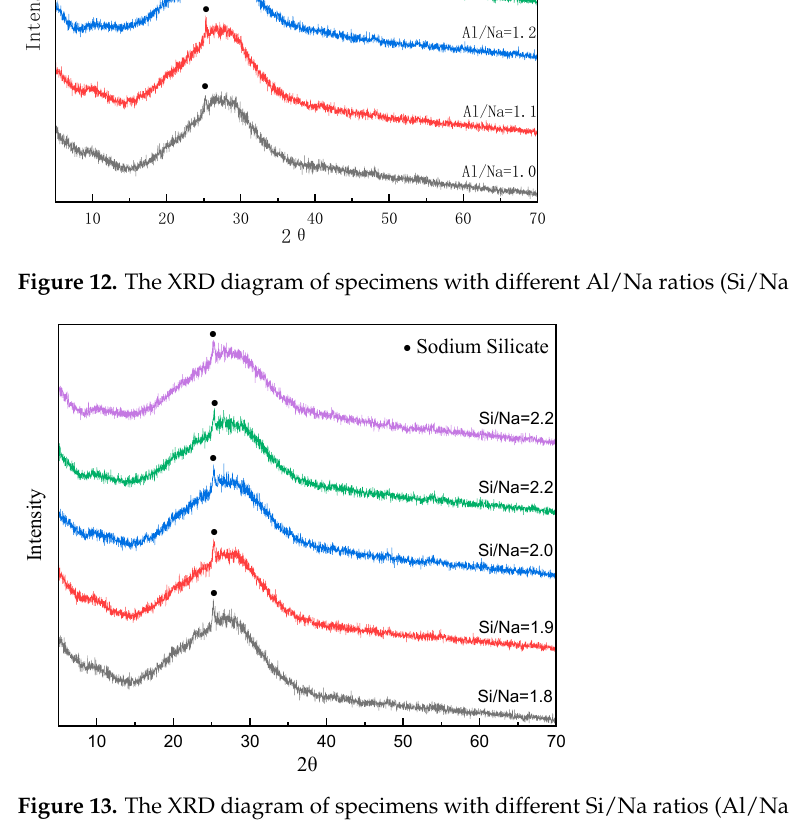
Figure 13. The XRD diagram of specimens with different Si/Na ratios (Al/Na = 1.3; age = 28